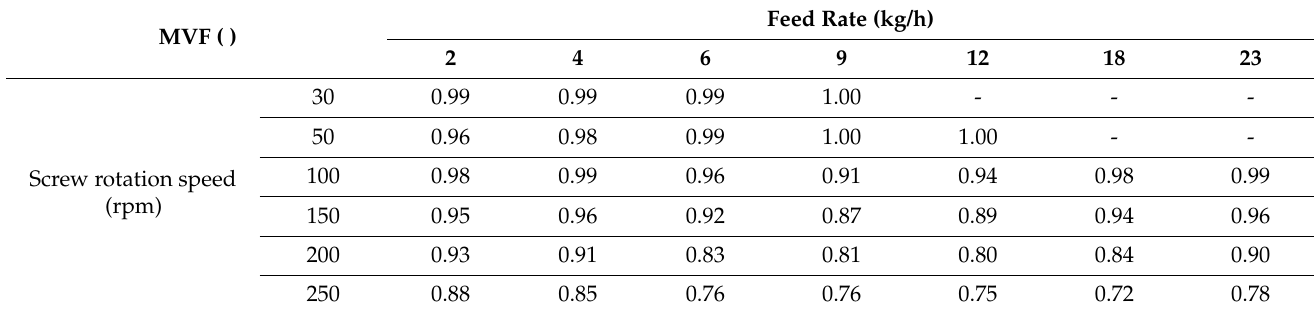
Table 3. Summary of molten volume fraction (MVF) dependence on increasing feed rate at a constant screw rotation speed: 2nd series *.